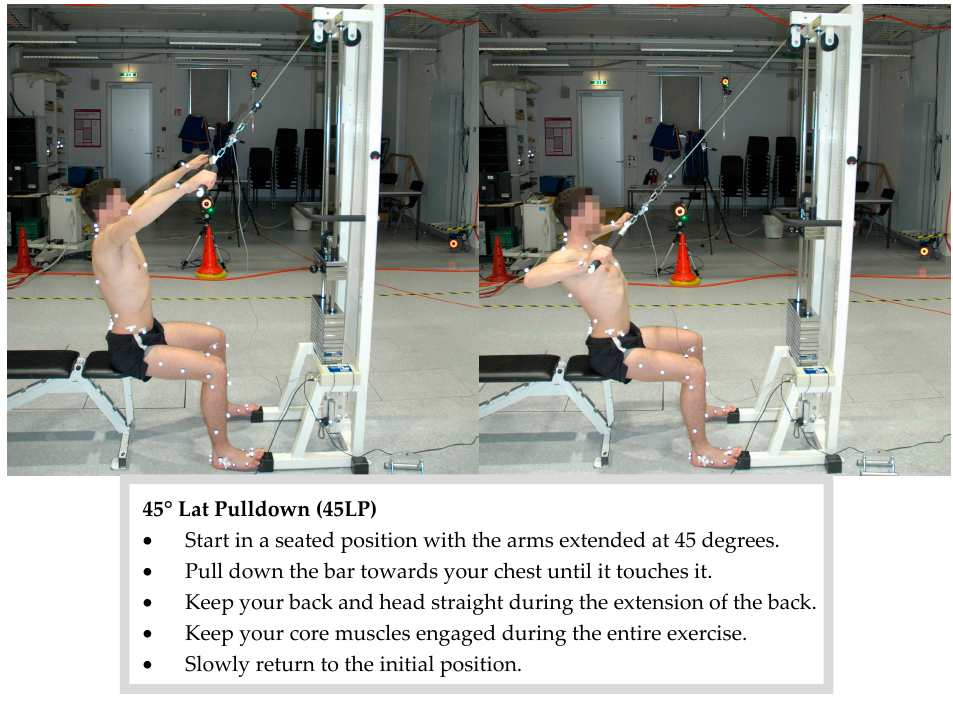
Figure A2. Experimental setup and execution of the 45° lat pulldown. The subject with a complete IfB marker set is shown.